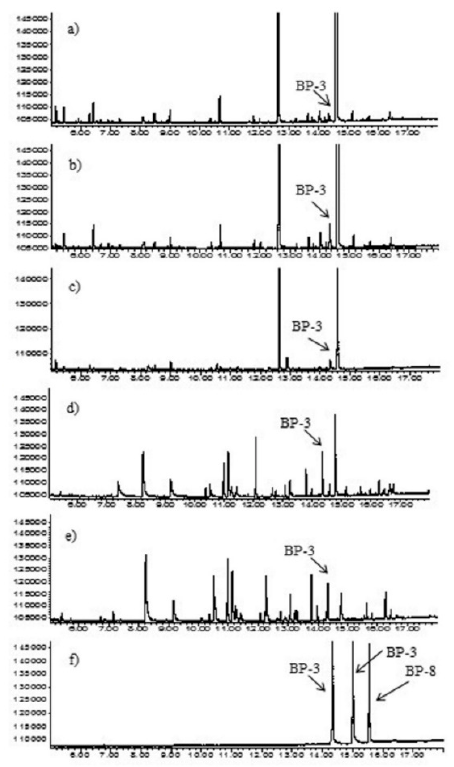
Figure 1. Chromatograms of ( a ) hair mask sample—SPE method; ( b ) hair mask sample with addition of BP-3 standard—SPE method; ( c ) hair mask sample—MEPS method; ( d ) shampoo sample–SPE method; ( e ) shampoo sample—MEPS method; ( f ) standard solution of BPs at concentration of 50 µg mL − 1 .